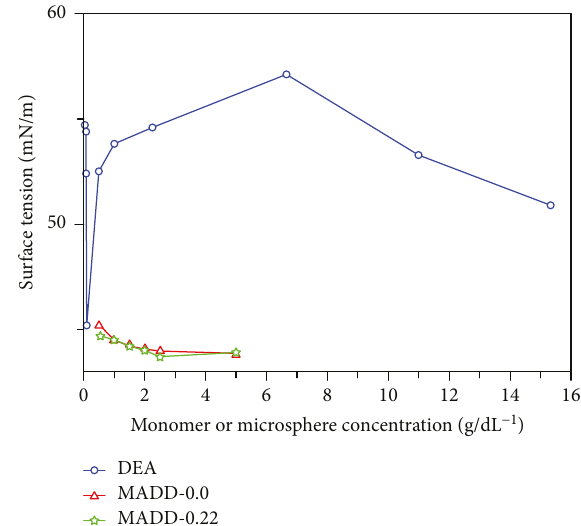
Figure 8: Relationship between surface tension and concentration for MAAE in 10176.6mg/L brine at 25.0 ± 0.1 °